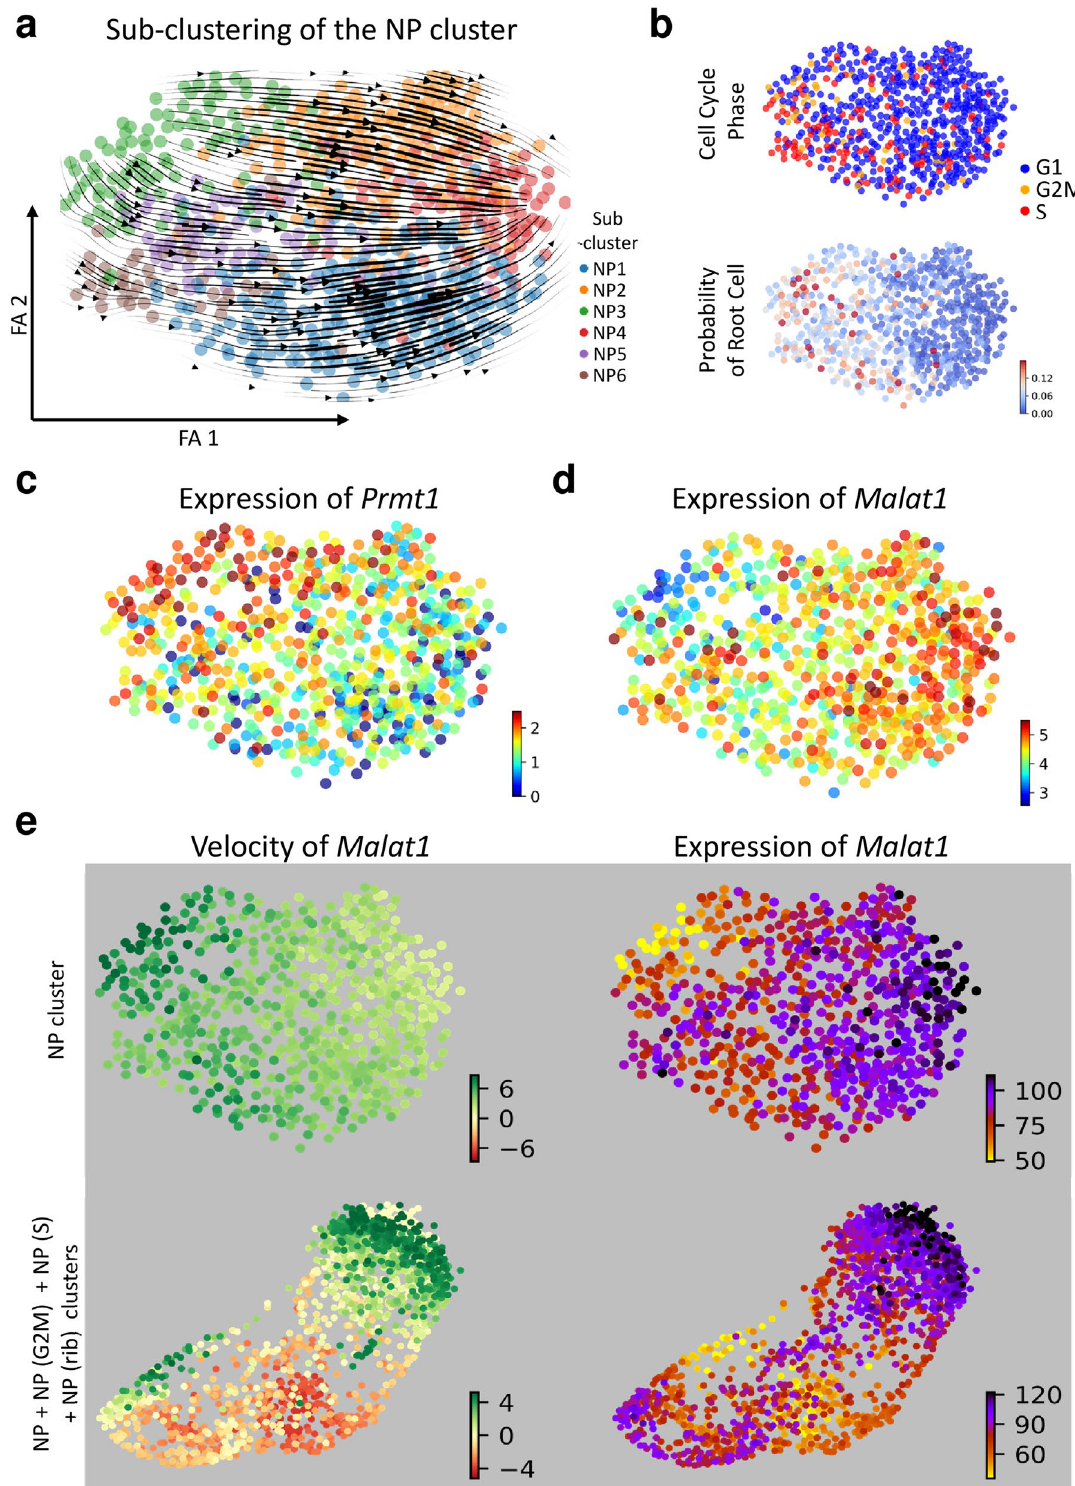
Figure 5. Analyses of cells belonging to the NP cluster. ( a ) The NP cluster cells have been extracted and then divided into six sub-clusters using the Louvain algorithm. Stream-embedded RNA velocities are overlaid. ( b ) The cell cycle phase and the probability of root cell in the NP cluster are visualized. ( c ) Expression levels of protein arginine methyltransferase 1 ( Prmt1) and metastasis associated lung adenocarcinoma transcript 1 ( Malat1) are visualized. ( e ) RNA velocity and mRNA expression levels of Malat1 in the NP cluster and the NP + NP(G2M) + NP (S) + NP (rib) clusters are shown. Data were analyzed using Scanpy version 1.4.4.post1 (https :// scanp y.readt hedoc s.io/en/stabl e/), scVelo version 0.1.25 (https ://scvel o.readt hedoc s.io/), and CellRank version 1.1.dev264+g61bbda4 (https ://cellr ank.readt hedoc s.io/en/stabl